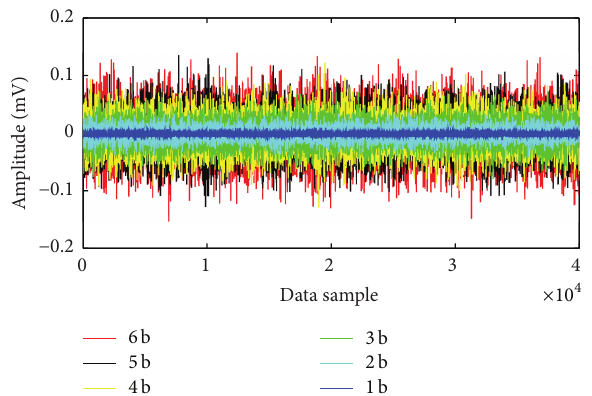
Figure 6: Raw AE signal due to VL through semicracked exhaust valve in cylinder 1.